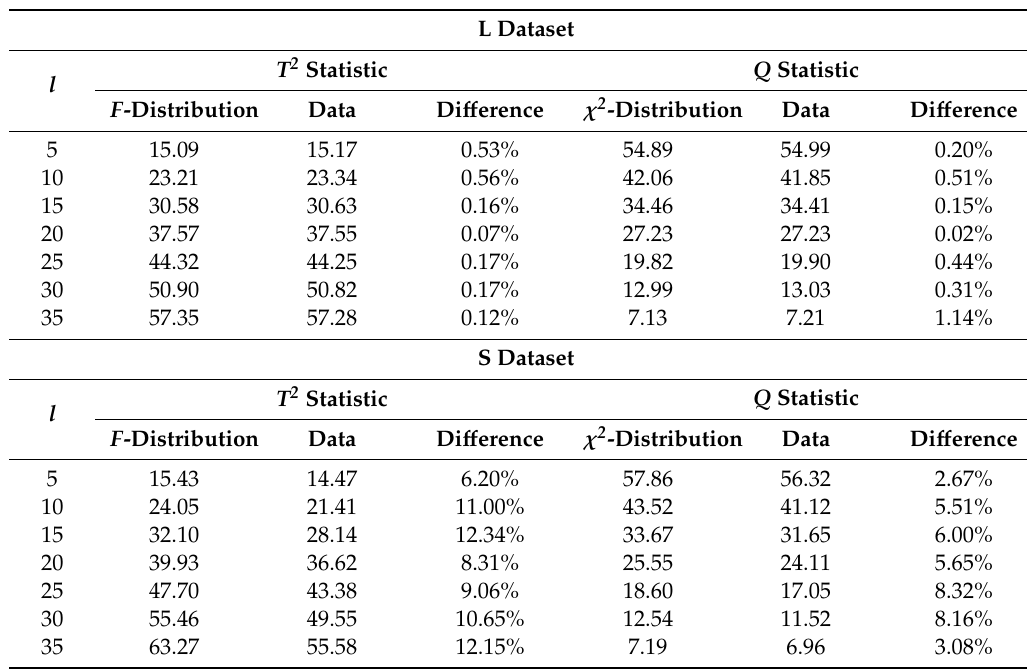
Table 2. Upper control limits calculated from the probability distributions and the